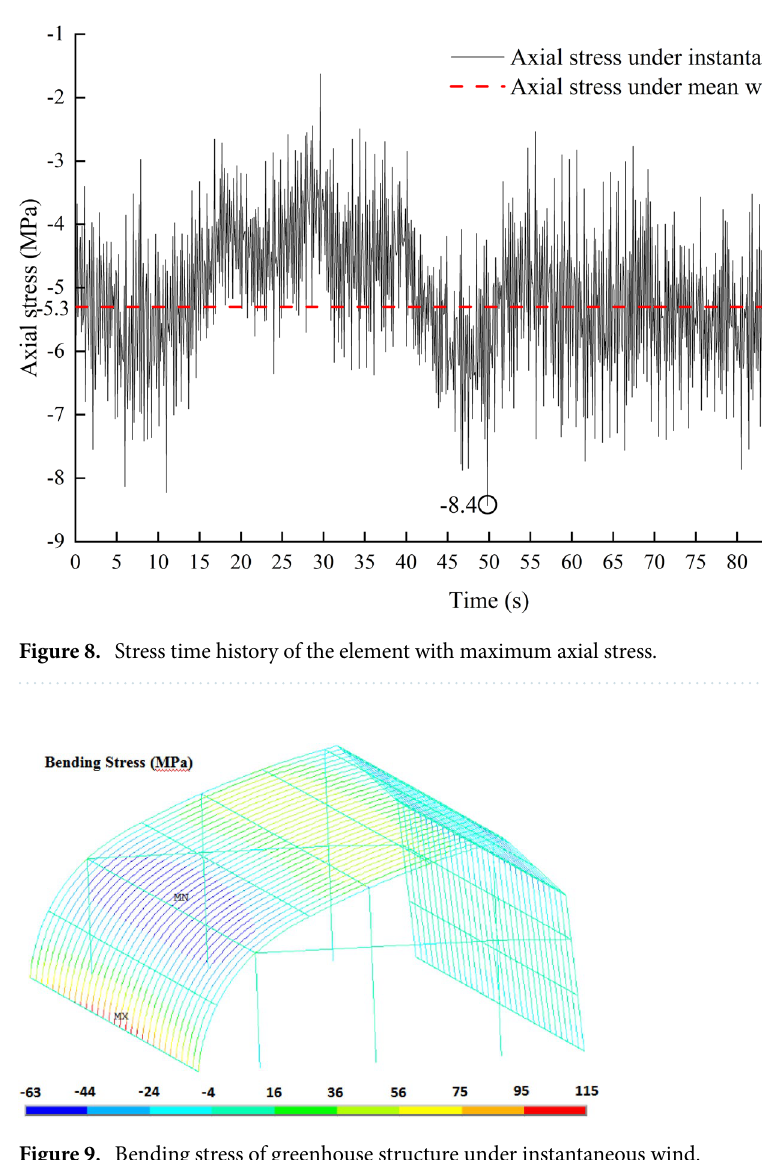
Figure 9. Bending stress of greenhouse structure under instantaneous wind.